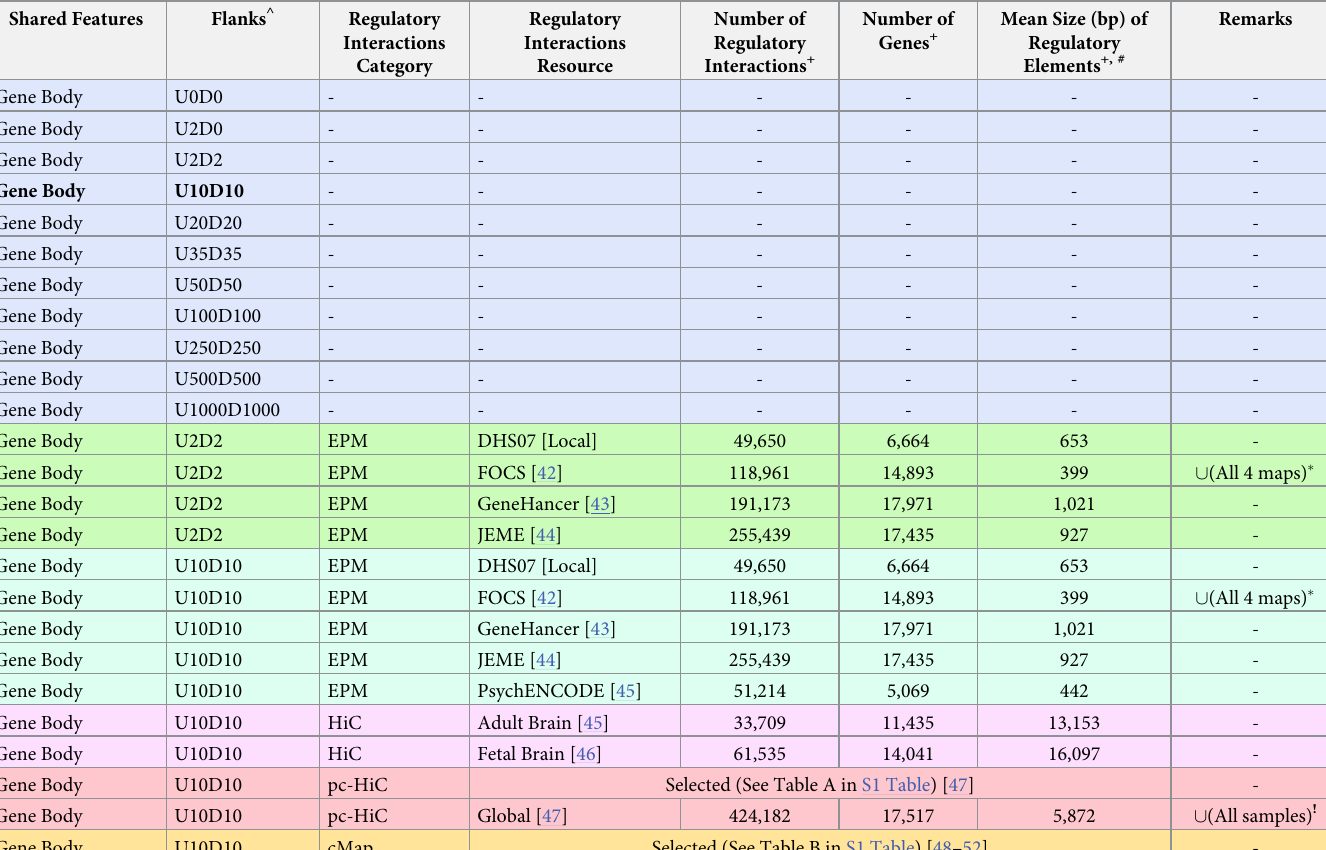
Table 1. Overview of SNV-to-gene mappings incorporated into our analyses (baseline model in bold font). Shared